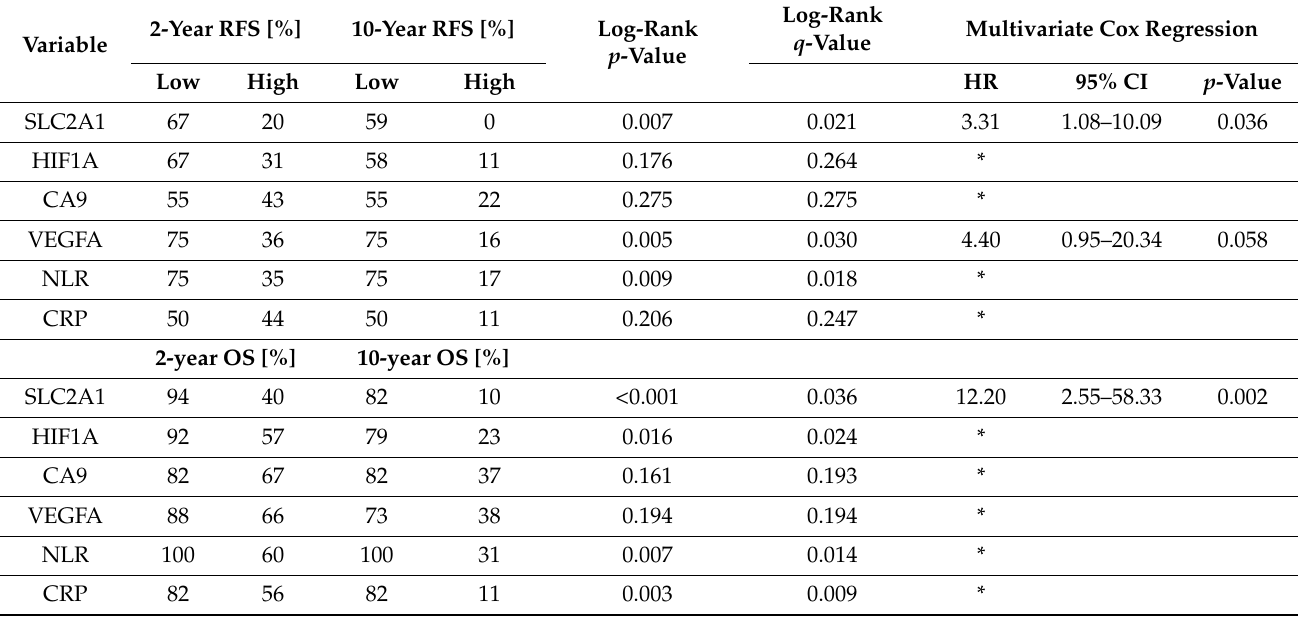
Table 5. Comparison of survival between groups with low and high expression of investigated